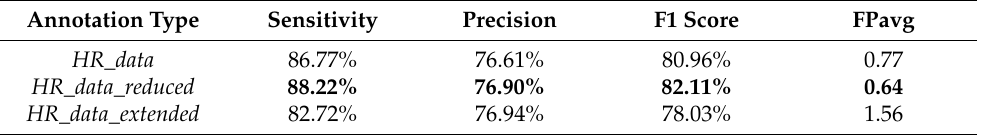
Table 4. Experiment results considering the type of data annotation. (The best result is marked in